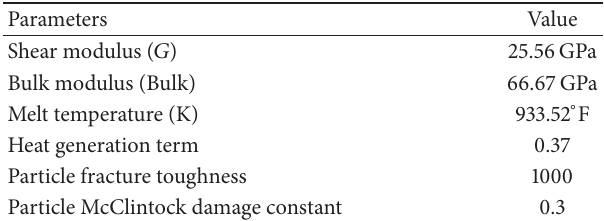
Table 1: Parameters of Al for